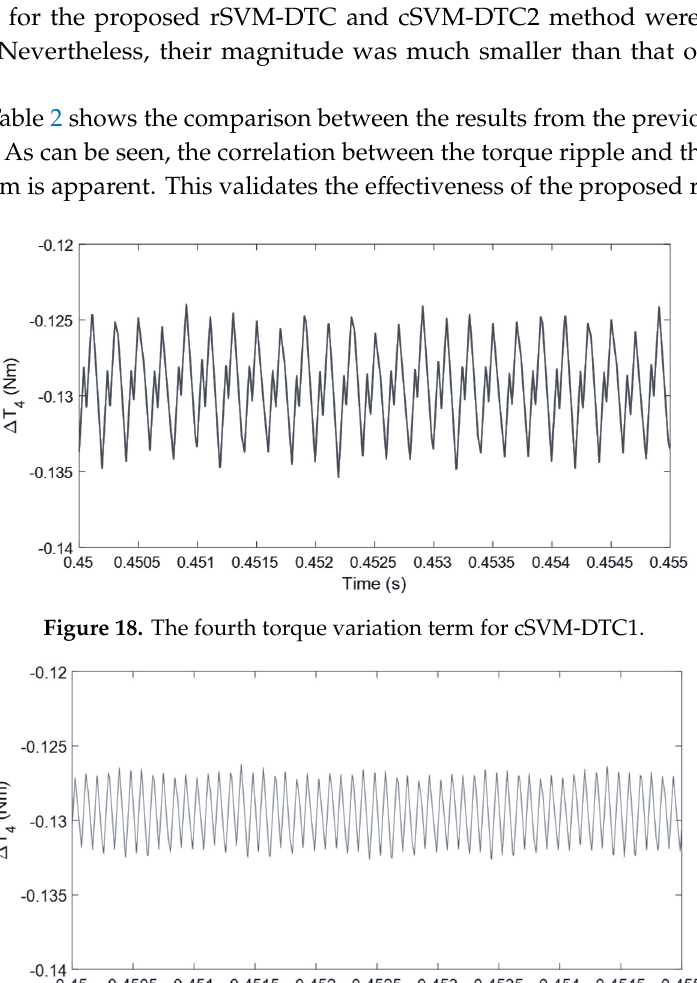
Figure 19. The fourth torque variation term for cSVM-DTC2.